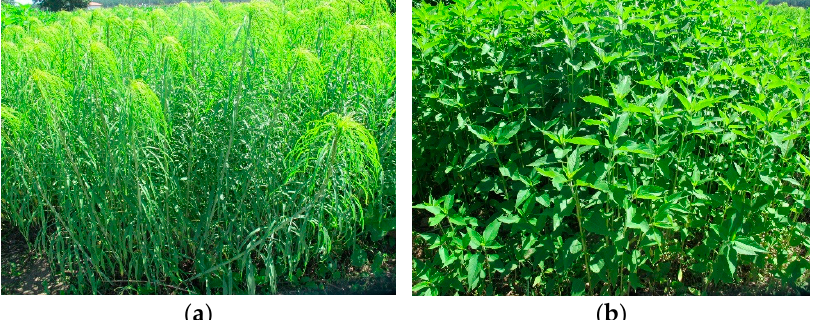
Figure 1. ( a ) H. salicifolius and ( b ) H. tuberosus plants during the harvest period June 24, 2019, (photo: M.J.S.).